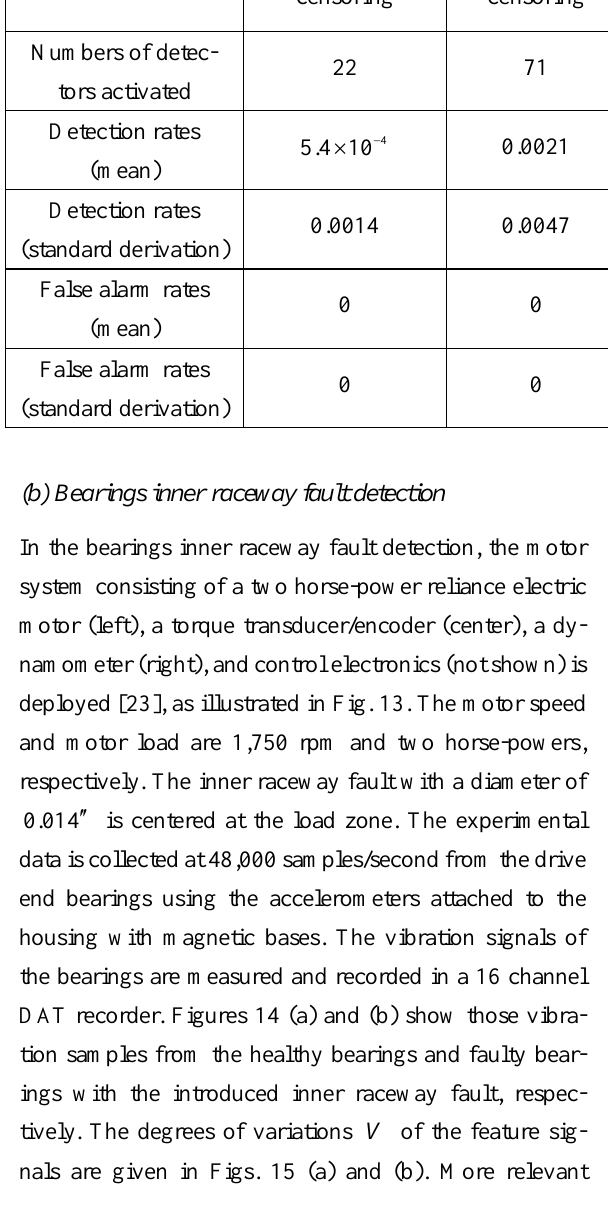
Fig. 14. Feature signals of bearings in Example 3 (b). (a) feature signal of healthy bearings, (b) feature signal of faulty bearings with inner raceway